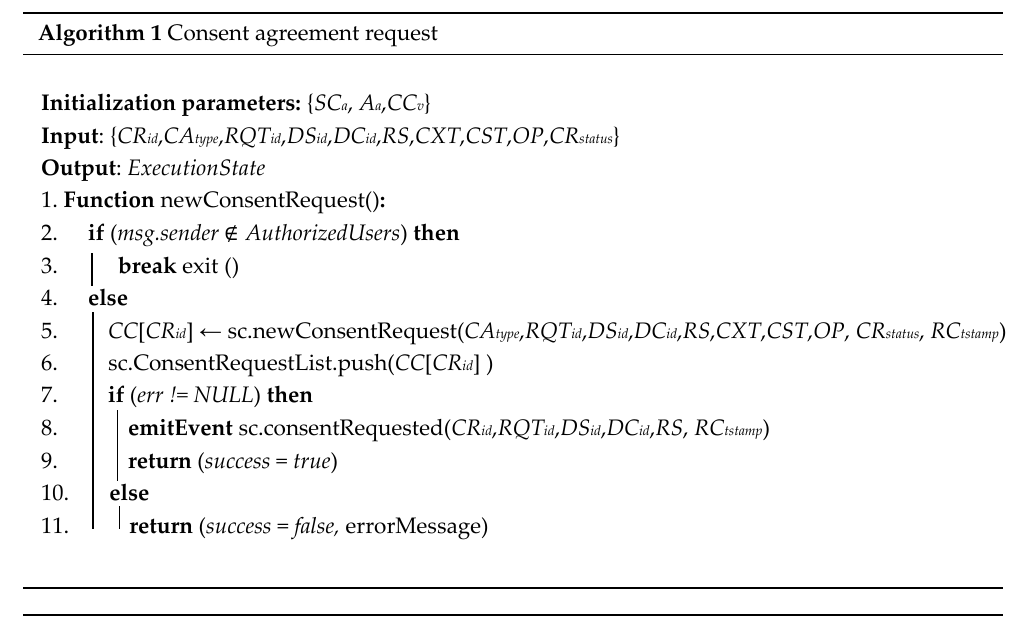
Algorithm 2 Consent agreement